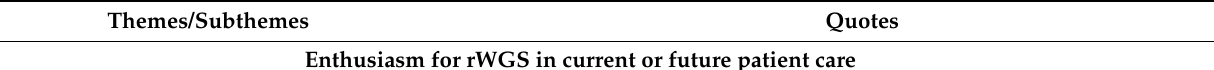
Table 5. Themes and illustrative quotes about rWGS implementation and wider